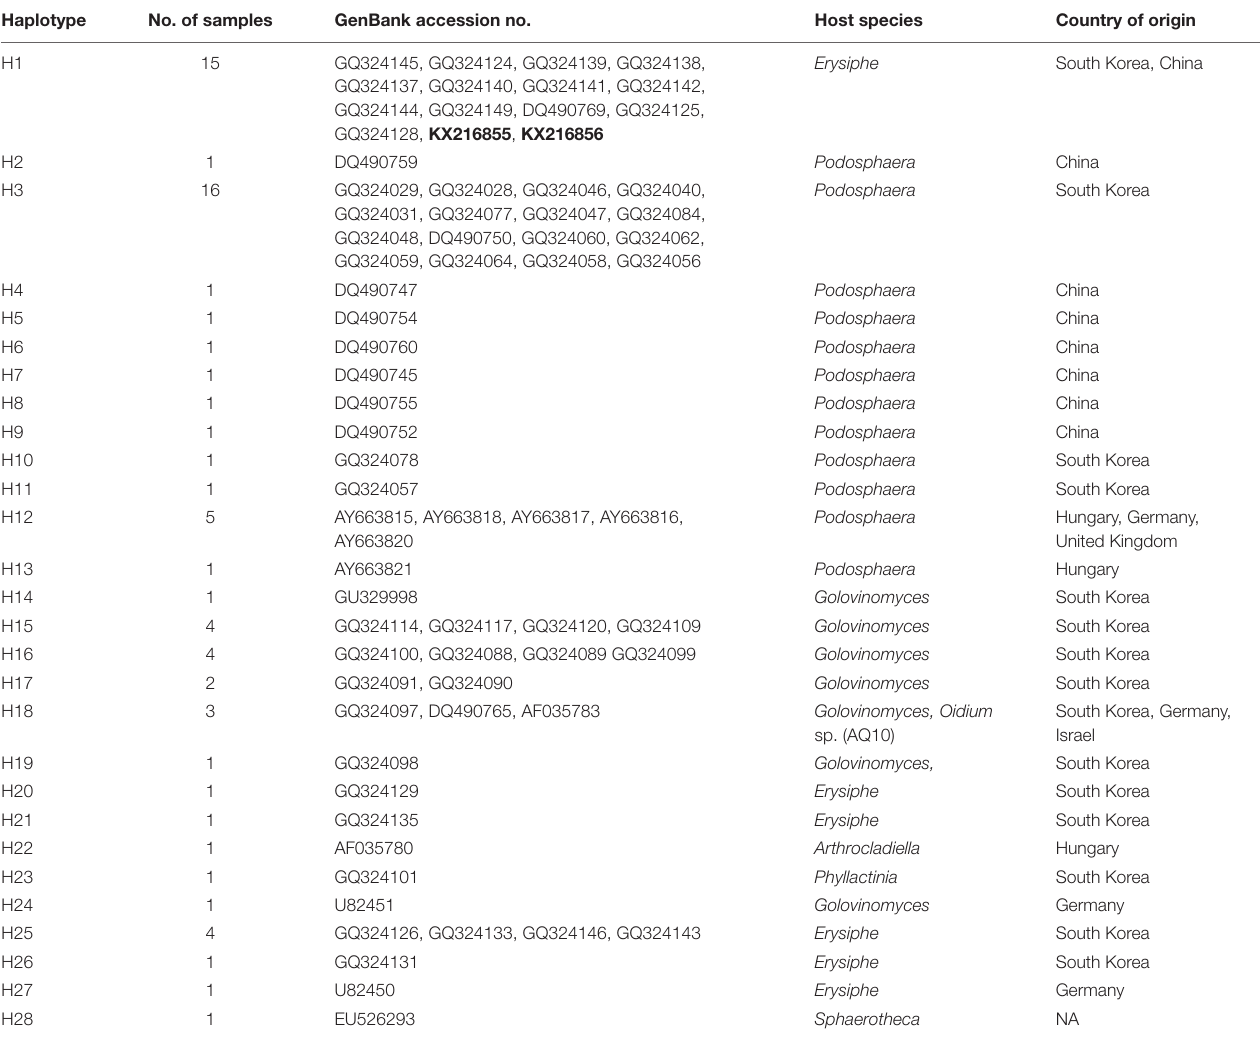
TABLE 1 | List of haplotypes with their host species, country of origin, and GenBank accession numbers. Haplotype No. of samples GenBank accession